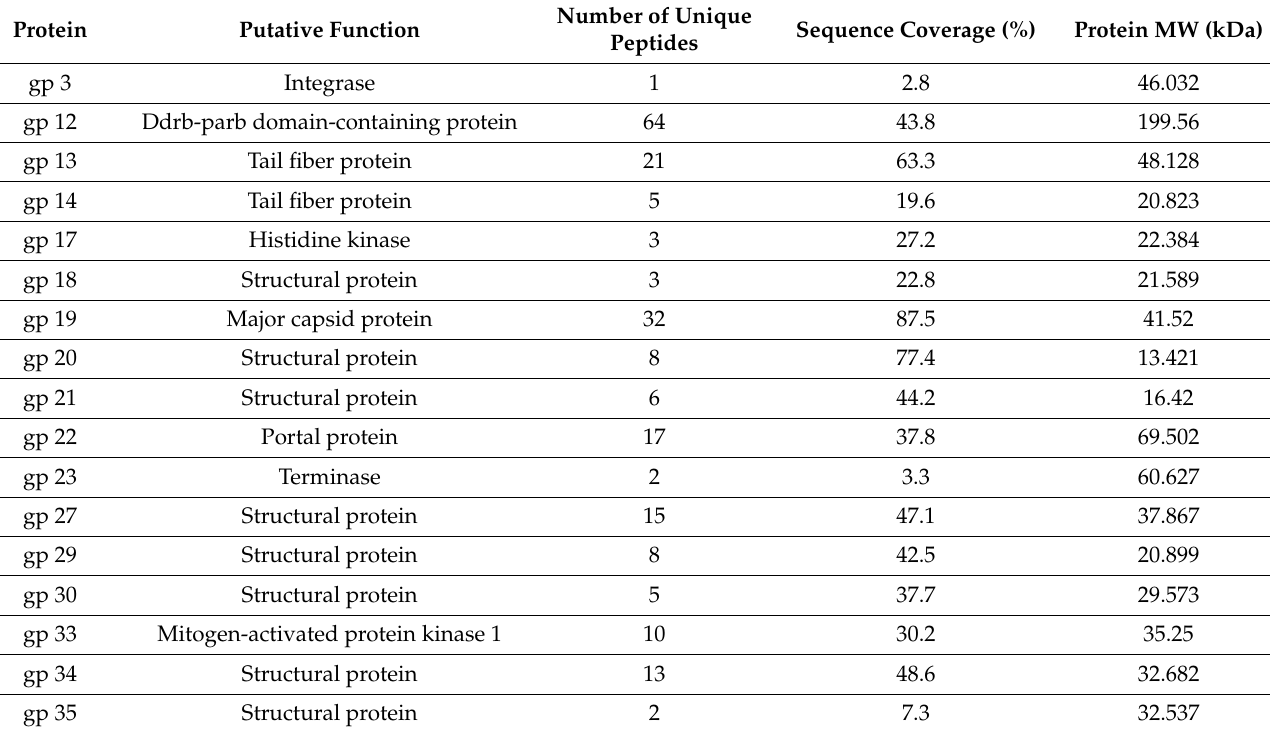
Table 2. Bacteriophage HPy1R proteins identified by ESI-MS/MS. The SDS–PAGE gel bands in which the proteins were identified are indicated as well as protein mass, the number of identified unique peptides, and the protein sequence that is covered by the peptide (in